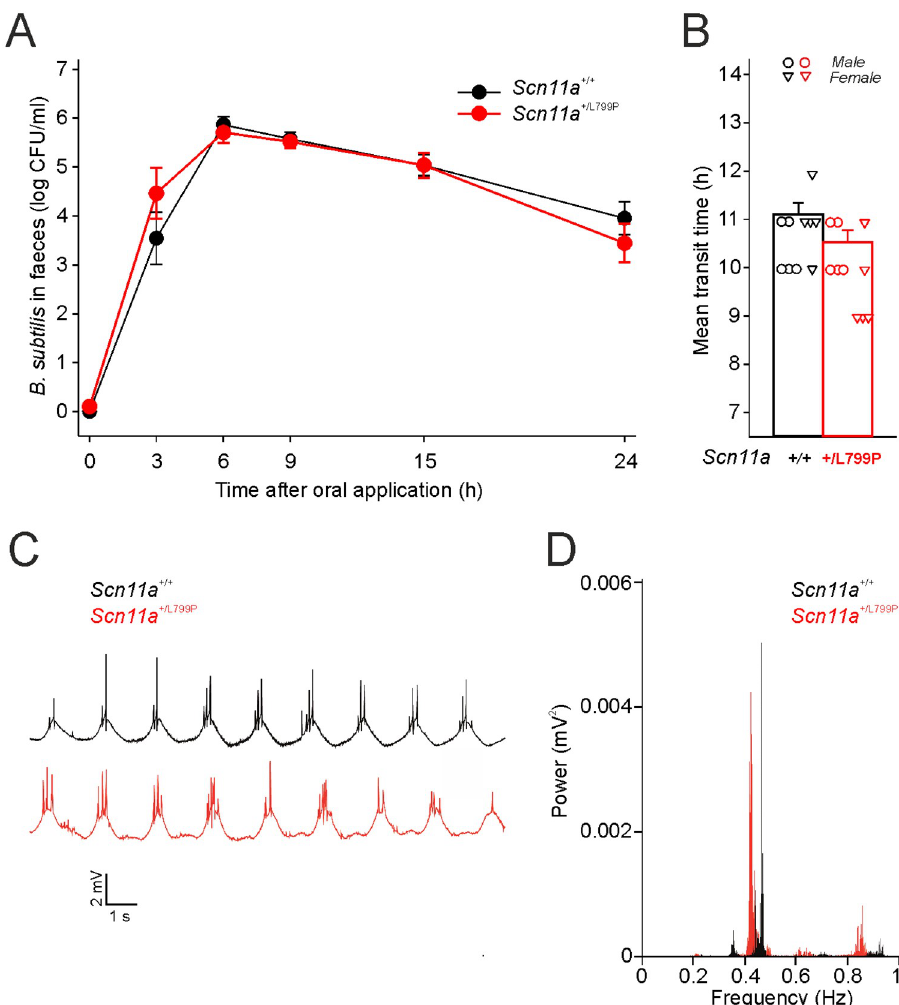
Fig 3. Gastrointestinal transit time (GITT) and spontaneous mechanical activity of the intestine. No significant differences between both genotypes were observed regarding GITT at individual time points of the experiment (A) and for the mean of GITT (B) (n = 10 per group, 4–7 months old). Representative field potential recordings (C) and power spectra of field potential recordings (D) of the Tunica muscularis of the small intestine indicate a slight shift towards less frequent spontaneous peristaltic in Scn11a +/L799P mice (n = 3 per group). Values are mean ± SEM. CFU colony forming unit.